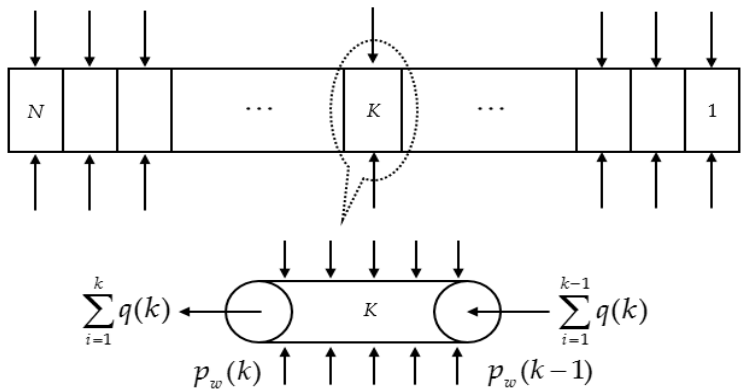
Figure 2. Schematic of the segmented horizontal well.